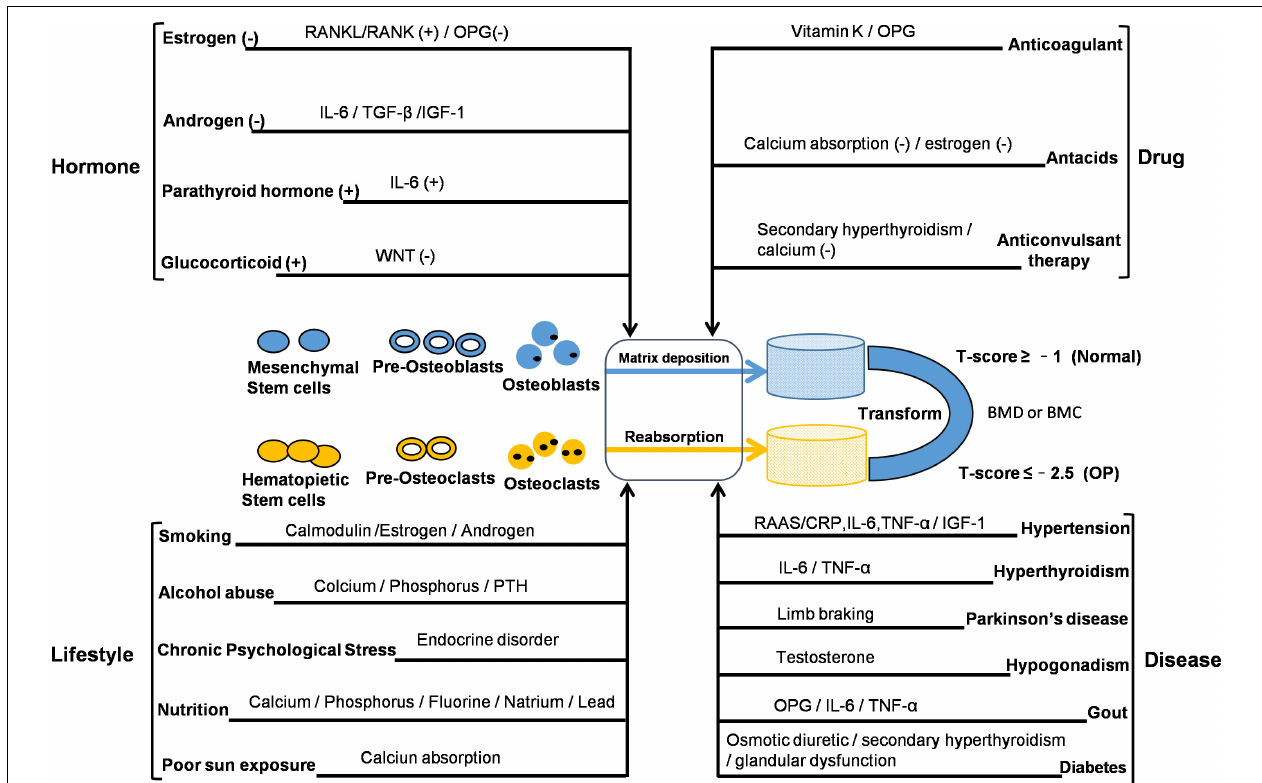
FIGURE 1 | Interactions between genetic and non-genetic factors in OP development. The reported factors may change the balance of bone remodeling. Bone density and structural integrity are dependent on bone-remodeling mechanisms associated with the function of osteocytes, osteoblasts, and osteoclasts. BMC, bone mineral content; BMD, bone mineral density; CRP, C-reactive protein; IL, interleukin; IGF, insulin-like growth factor; OPG, osteoprotegerin; PTH, parathyroid hormone; RAAS, renin angiotensin aldosterone system; RANK, receptor activator for nuclear factor- κ B; RANKL, receptor activator for nuclear factor- κ B ligand; TGF, transforming growth factor; TNF, tumor necrosis factor; (+): increase or promote; (–): reduce or